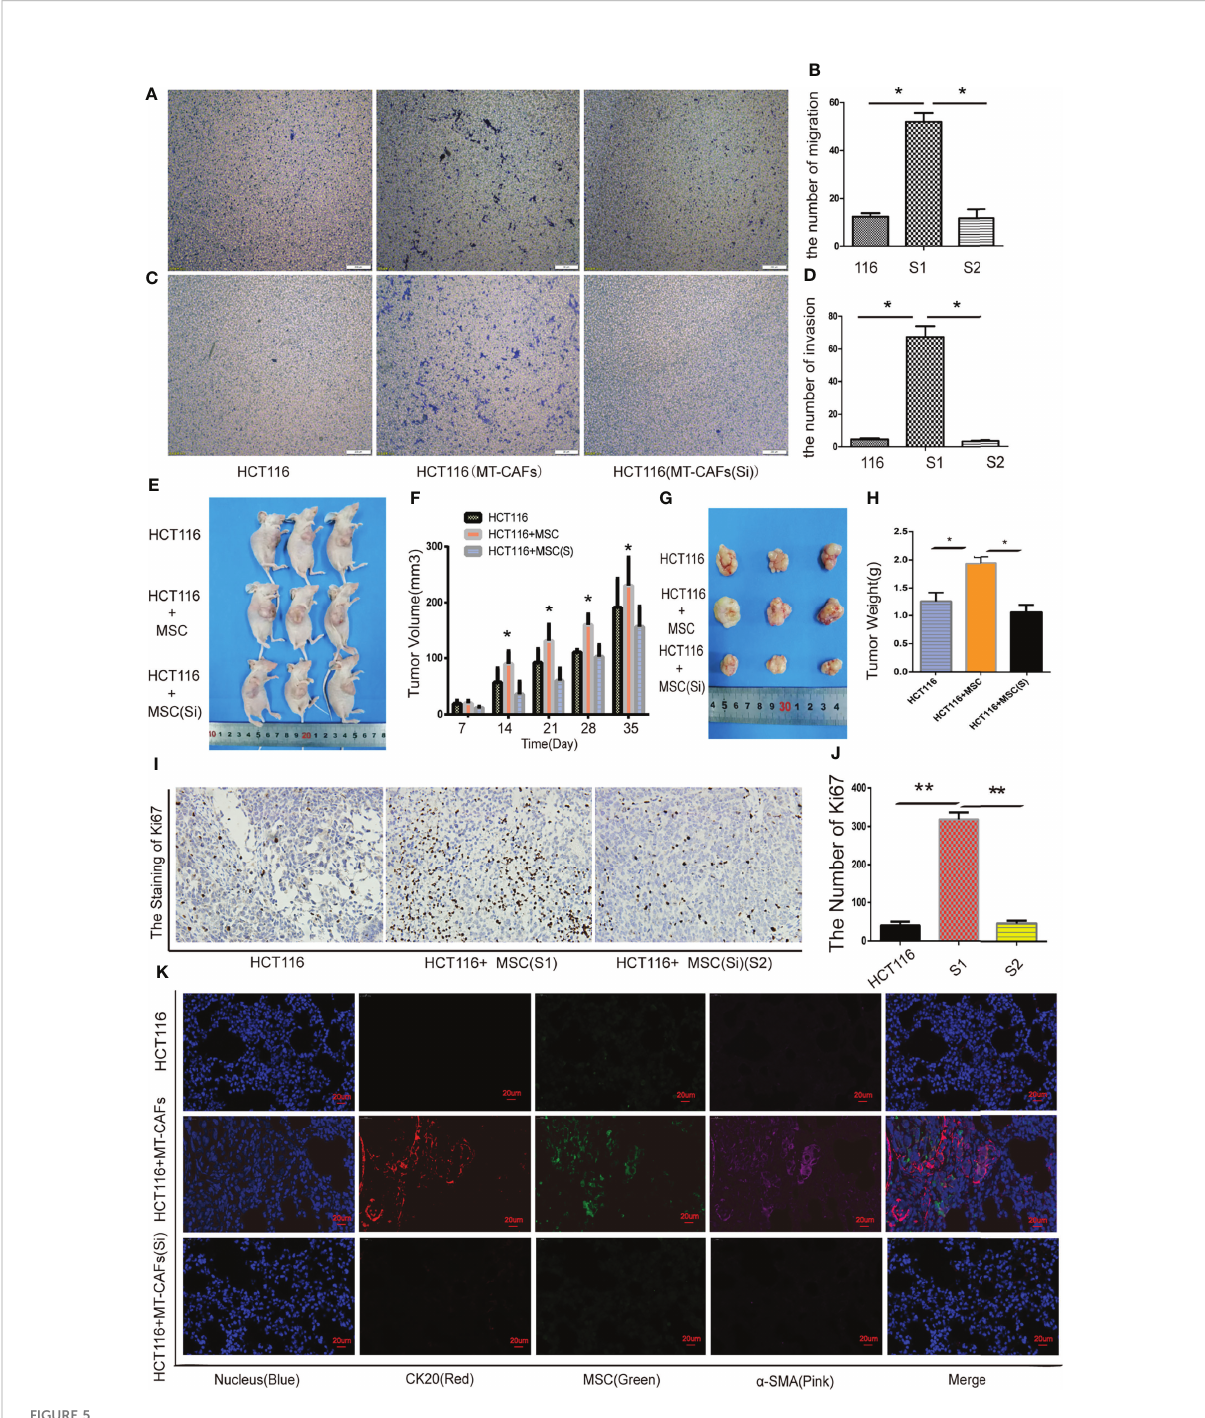
FIGURE 5 ICAM-1 from MTCAFs in fl uences the progression of colon cancer cells. (A, B) Transwell migration assays to evaluate the HCT116 cells migration capacity were also performed. Panel (A) indicates a representative microscopic image of the crystal violet staining. Panel (B) shows the quantitative results. (C, D) Transwell assays to evaluate the HCT116 cells invasion capacity were also performed. Panel (C) indicates a representative microscopic image of the crystal violet staining. Panel (D) shows the quantitative results. (E) Representative photographs of HCT116 tumors generated in nude mice eco-implanted with MSCs (S1), MSCs after ICAM-1 silencing (S2), or PBS (NC) at a ratio of 5:1. (F) The quantitative data referent to (E) . (G) The weight (g) of tumors were discorded. (H) The quantitative data referent to (G) . (I, J) The expression of Ki67 in tumor tissue of mice in S1, S2, and NC groups was detected by immunohistochemistry. (J) The quantitative data. (K) MSCs and HCT116 density were measured using immuno fl uorescence staining in mice lung tissue (CK20, red, represents colorectal cancer cells; a -SMA, pink, represents MTCAFs; green, fl uorescent protein carried by MSCs; and Hoechst3342, blue, represents the nucleus. *p<0.05, **p<0.01, and